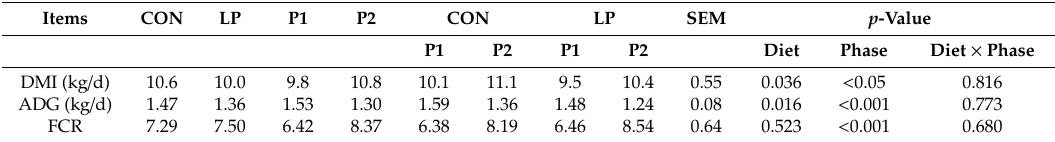
Table 2. The e ff ects of high protein (CON) and low protein (LP) diets, on dry matter intake (DMI), average daily gain (ADG) and feed conversion ratio (FCR) by young Charolais beef bulls at Rovigo Province, Italy, during growing (P1) and finishing (P2) phases. Data are the means of 5 or 6 pens and 9 to 10 animals per pen.